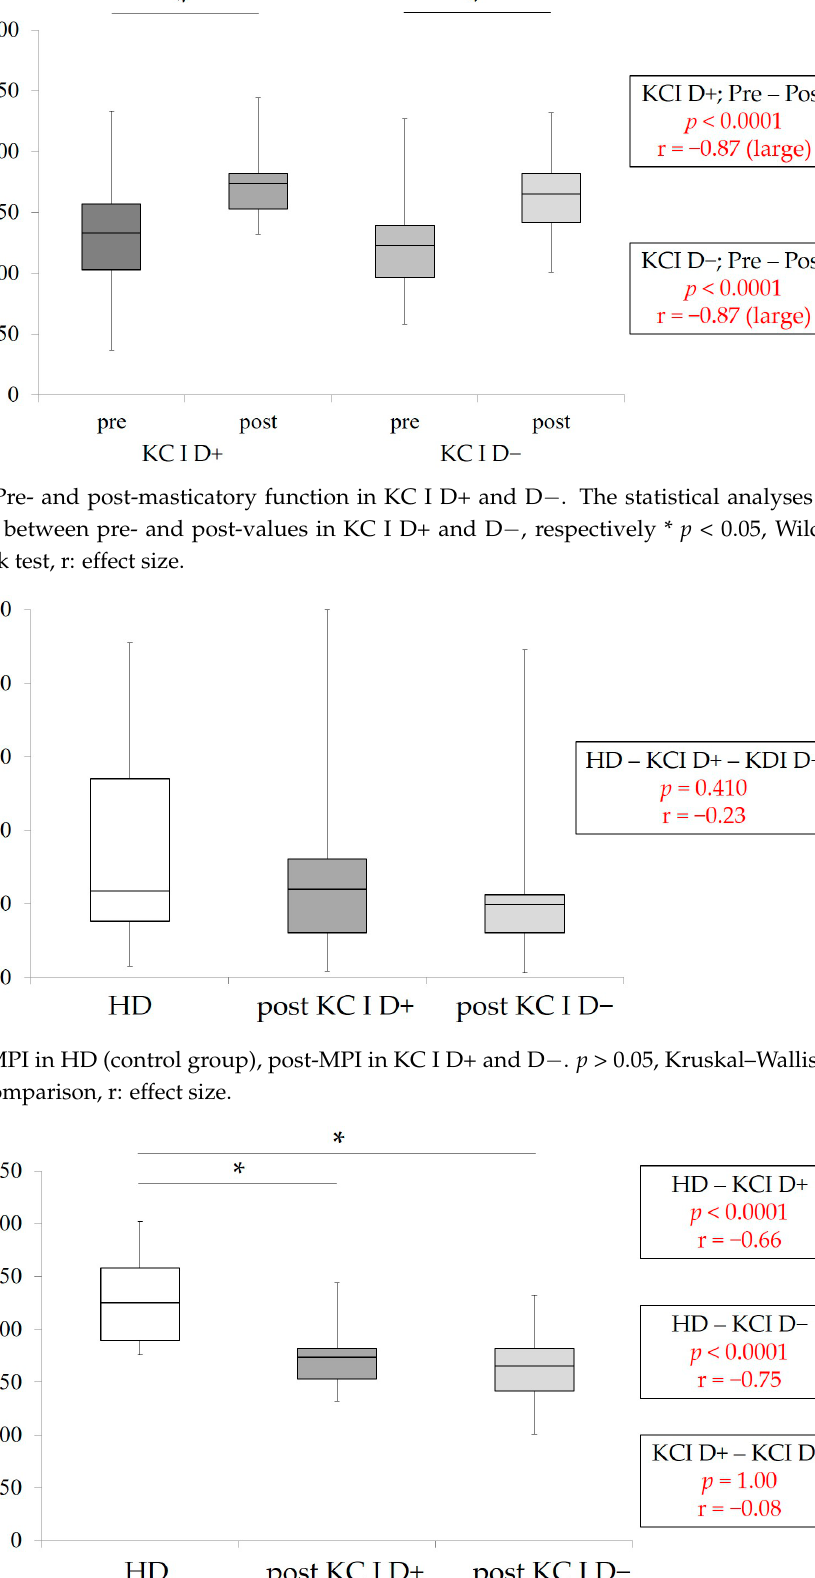
Figure 6. Masticatory function in HD (control group), post-masticatory function in KC I D+ and D − . * p < 0.001, Kruskal–Wallis with multiple comparison, r: effect size.